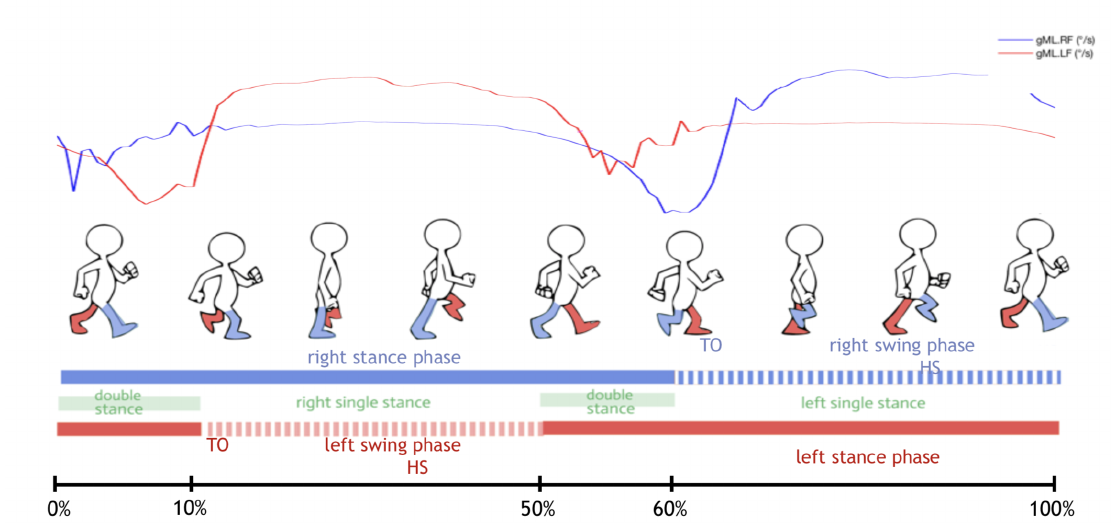
Figure 1. Key phases of the Gait Cycle, represented schematically, and put in parallel of angular velocity signals, obtained by two foot-mounted Xsens